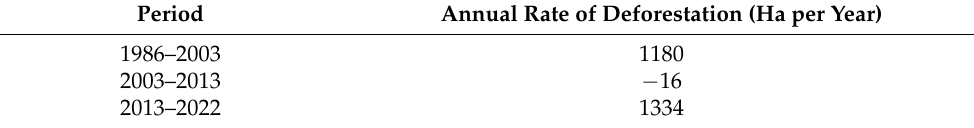
Table 5. Annual Deforestation